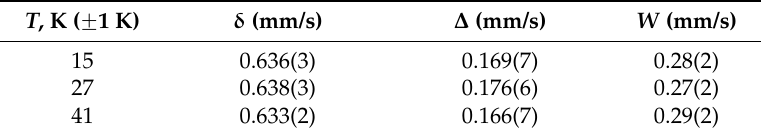
Table 3. Hyperfine parameters of the 57 Fe Mössbauer spectra of Eu 7 Cu 36 Fe 8 As 23 at different temperatures; δ is the isomer shift, ∆ is the quadrupole splitting, and W is the linewidth. T , K (±1 K) δ (mm/s) ∆ (mm/s)